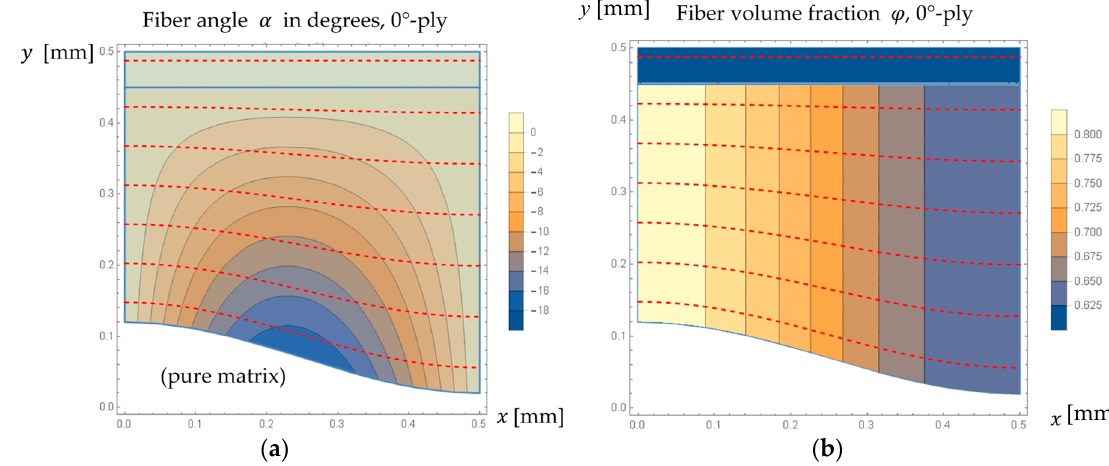
Figure 6. Controlled fiber placement (CFP) in the micro model: ( a ) fiber orientation defined by Equation (1) ( b ) variation in volume fraction within the micro-mechanical model.